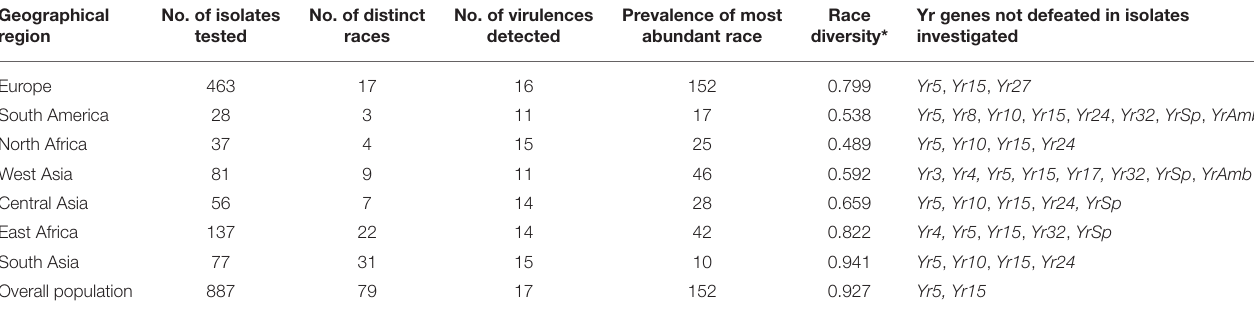
TABLE 3 | Diversity for race and virulence in P. striiformis populations sampled from worldwide geographical regions during 2009–2015. Geographical